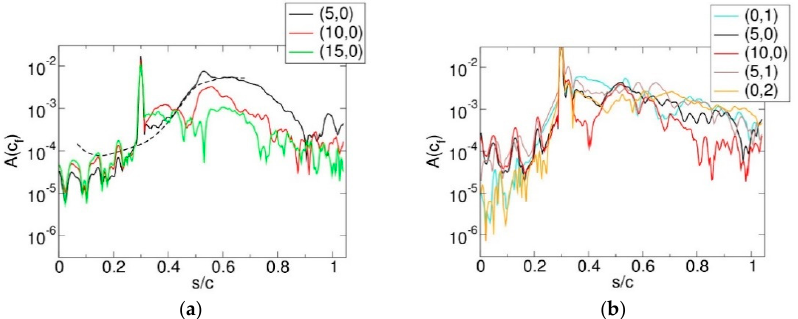
Figure 29. Top surface skin friction coefficient Fourier amplitudes (dashed lines: LST, solid lines: simulation) for pulsed VGJs with ( a ) B = 1 and ( b ) B = 4.